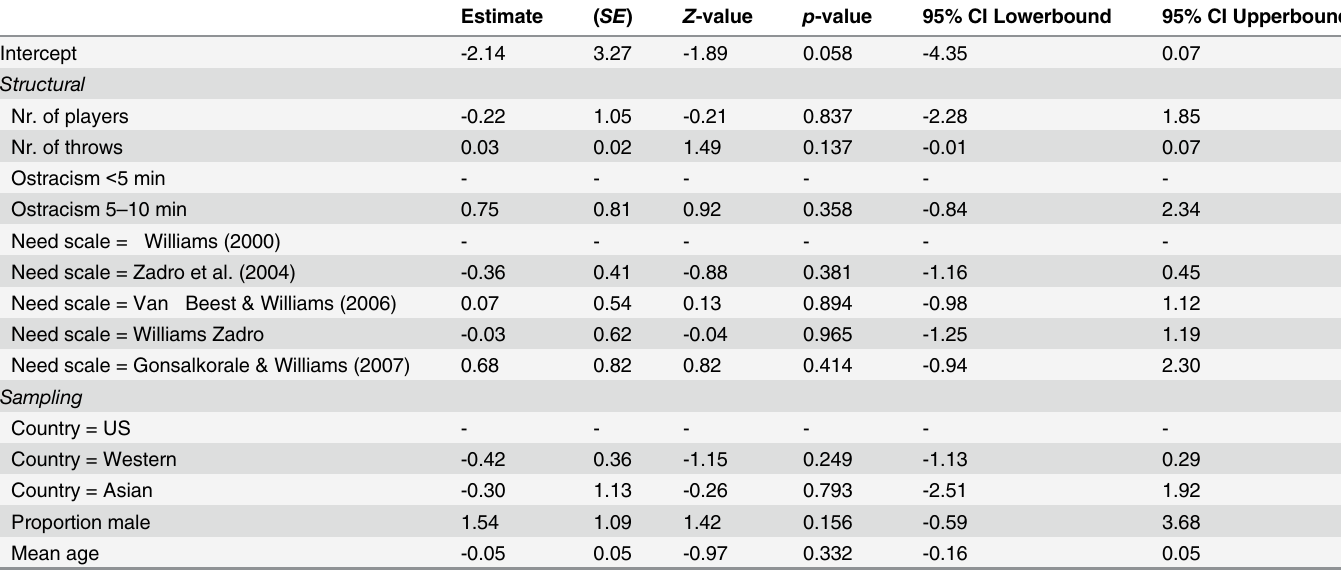
Table 4. Meta regression coefficients for composition effects (first measure; k = 45).